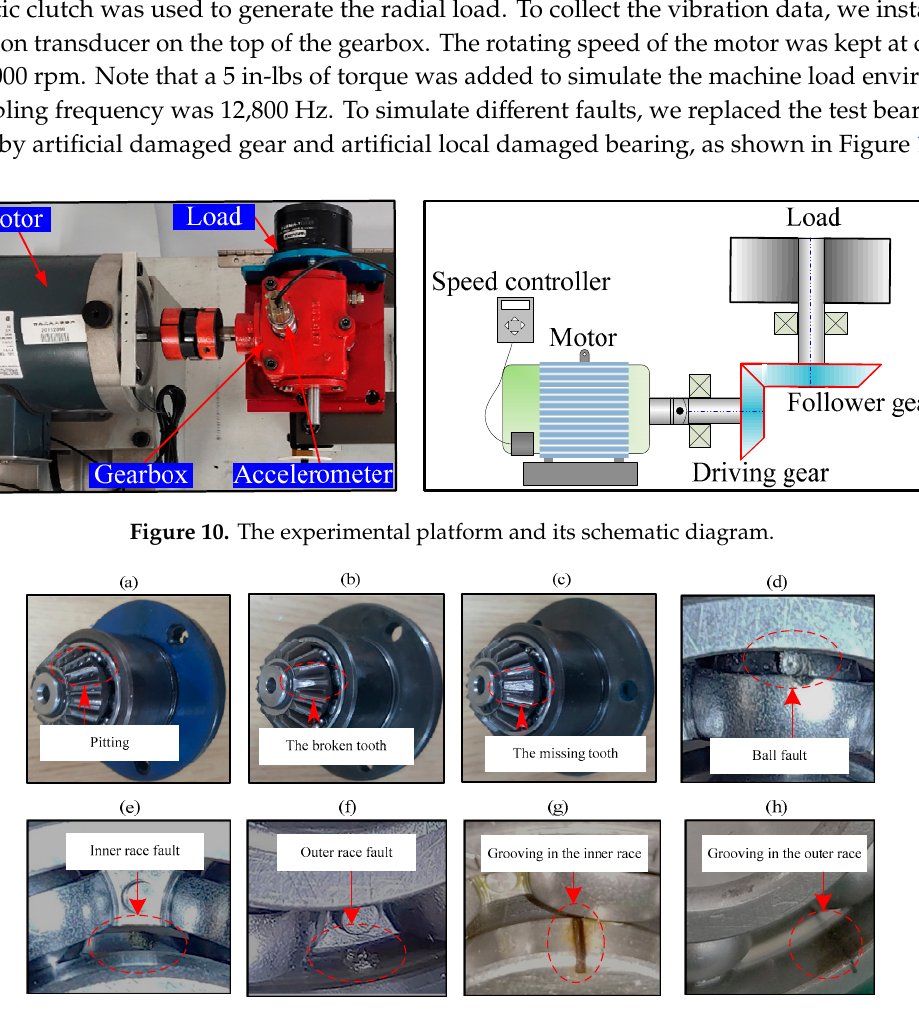
Figure 9. Flowchart of the proposed fault diagnosis method.